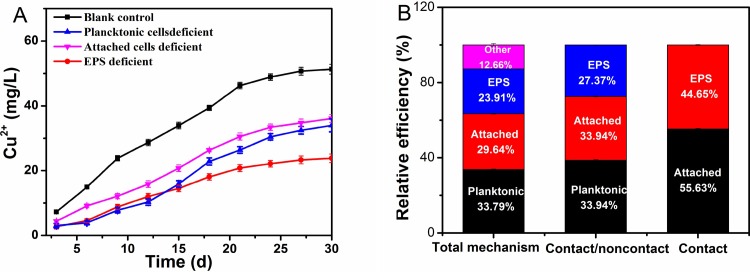
Changes in copper ions in different systems and relative bioleaching efficiencies of different mechanisms.(A): Copper ion; (B): Relative bioleaching efficiencies of different mechanisms.